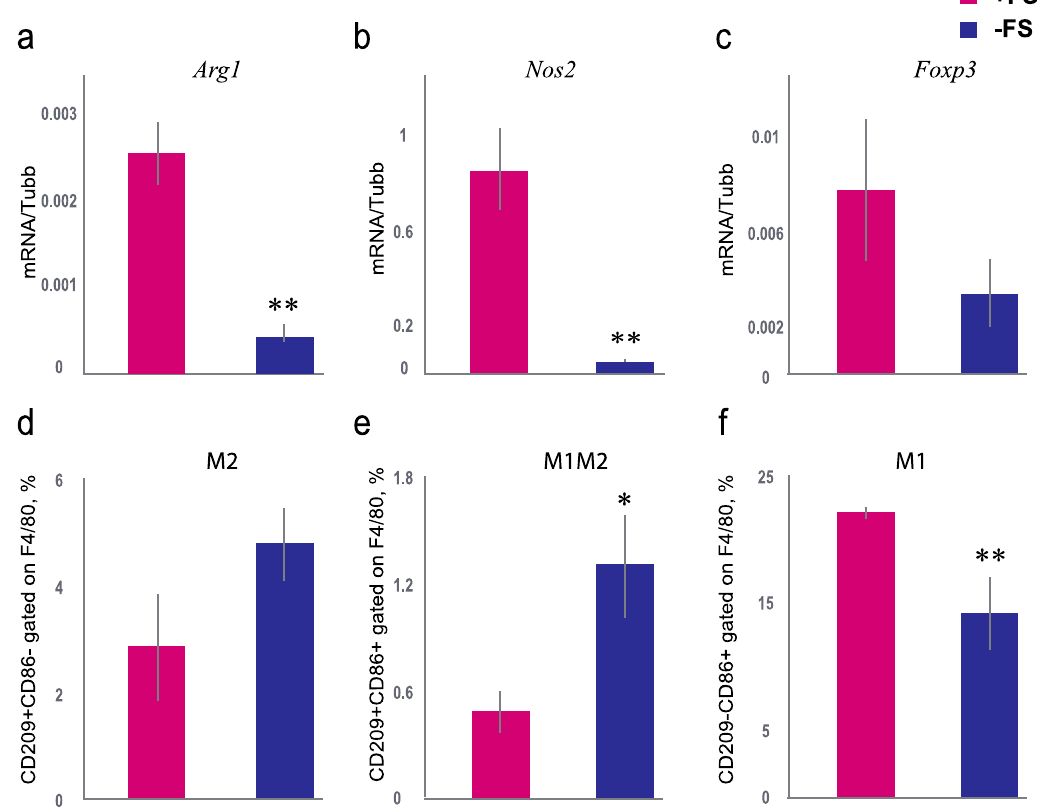
Figure 3. Effect of exposure to female scent on the expression of Arg1 , Nos2 , and Foxp3 genes in the lung of male mice and percentage of macrophages of M1 and M2 types in broncho-alveolar lavage. ( a ) The expression of Arg1 level in the lung for the +FS group (red column) and − FS group (blue column) measured by RT-PCR. ( b ) The expression of Nos2 mRNA level in the lung for the +FS group (red column) and − FS group (blue column) measured by RT-PCR. ( c ) The expression of Foxp3 mRNA level in the lung for the +FS group (red column) and − FS group (blue column) measured by RT-PCR. The mRNA level of Tubb5 (Tubulin, beta 5 class I) used as an internal standard. ( d ) The percentage of M2 type macrophages in broncho-alveolar lavage for +FS group (red column) and − FS group (blue column). ( e ) The percentage of boarding M1M2 type macrophages in broncho-alveolar lavage for +FS group (red column) and − FS group (blue column). ( f ) The percentage of M1 type macrophages in broncho-alveolar lavage for +FS group (red column) and − FS group (blue column). *- p < 0.05, **- p < 0.01 Mann–Whitney U-test. Data are presented as the mean ± standard